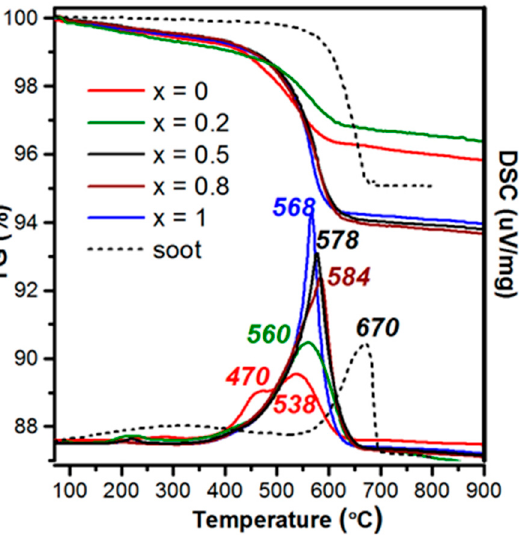
Figure 5. TGA and DSC curves for soot oxidation over GdFe 1 − x Co x O 3 (x = 0; 0.2; 0.5; 0.8; 1)